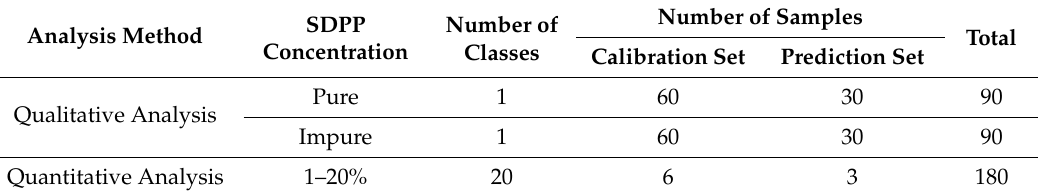
Table 1. Information on the test samples prepared for both electronic nose (EN) and near-infrared spectroscopy